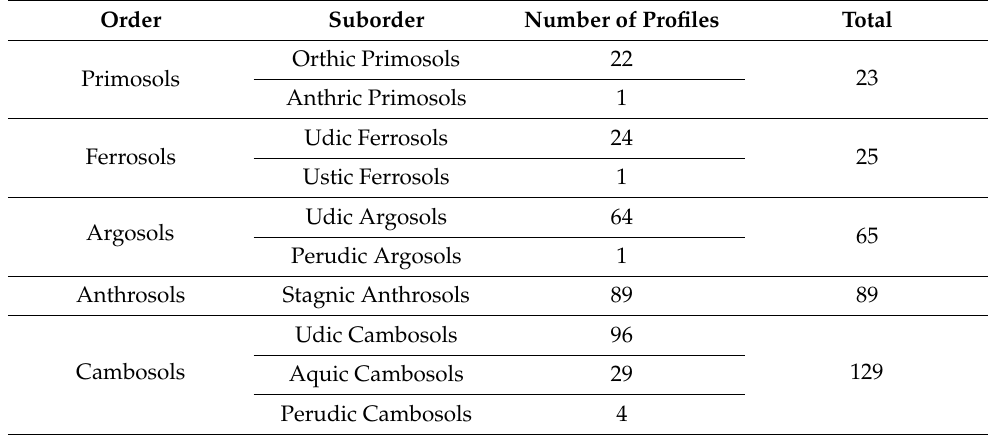
Table 1. Suborders to which the soil at the profile sampling site belongs.